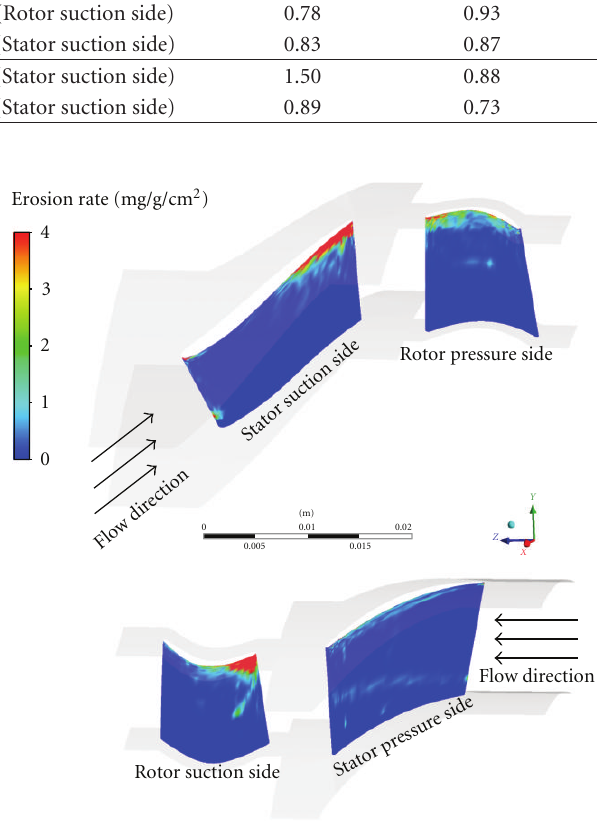
Figure 14: TBC erosion rates on blade surfaces in the NASA- designed turbine for uniform particle loading at 50% of the gas velocity.